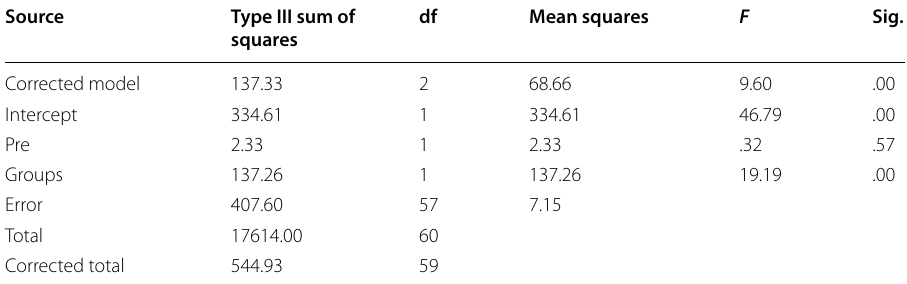
Table 4 One-way ANCOVA (EG and CG RC post-tests) Source